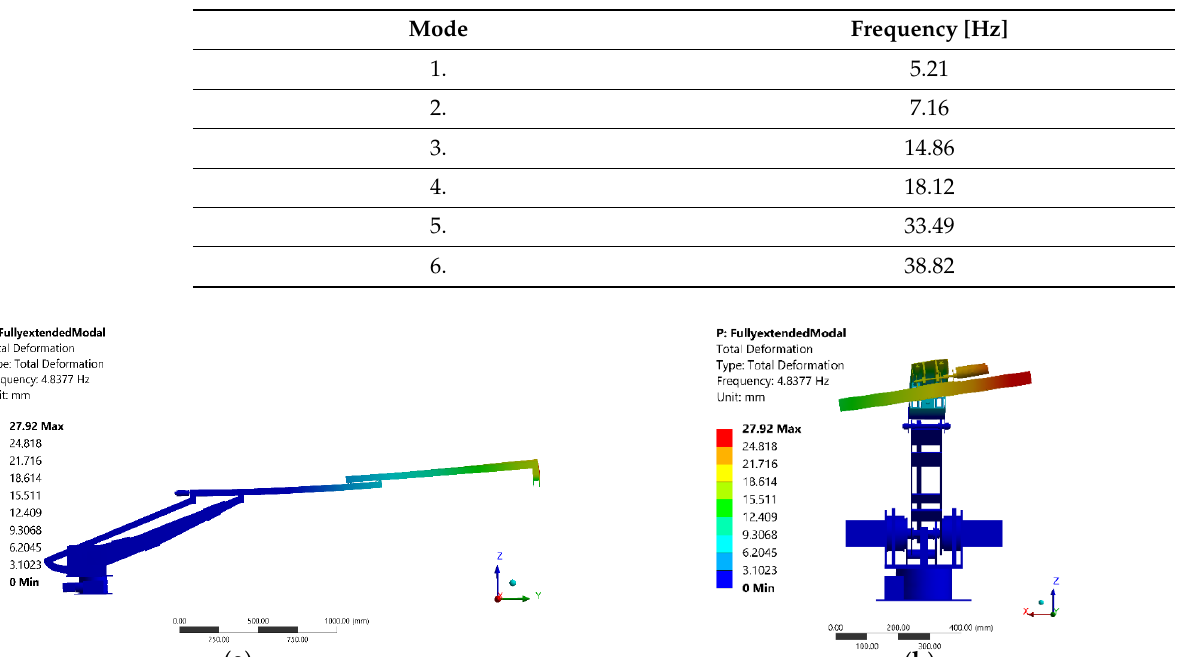
Table 3. Natural frequencies of the half-extended configuration.